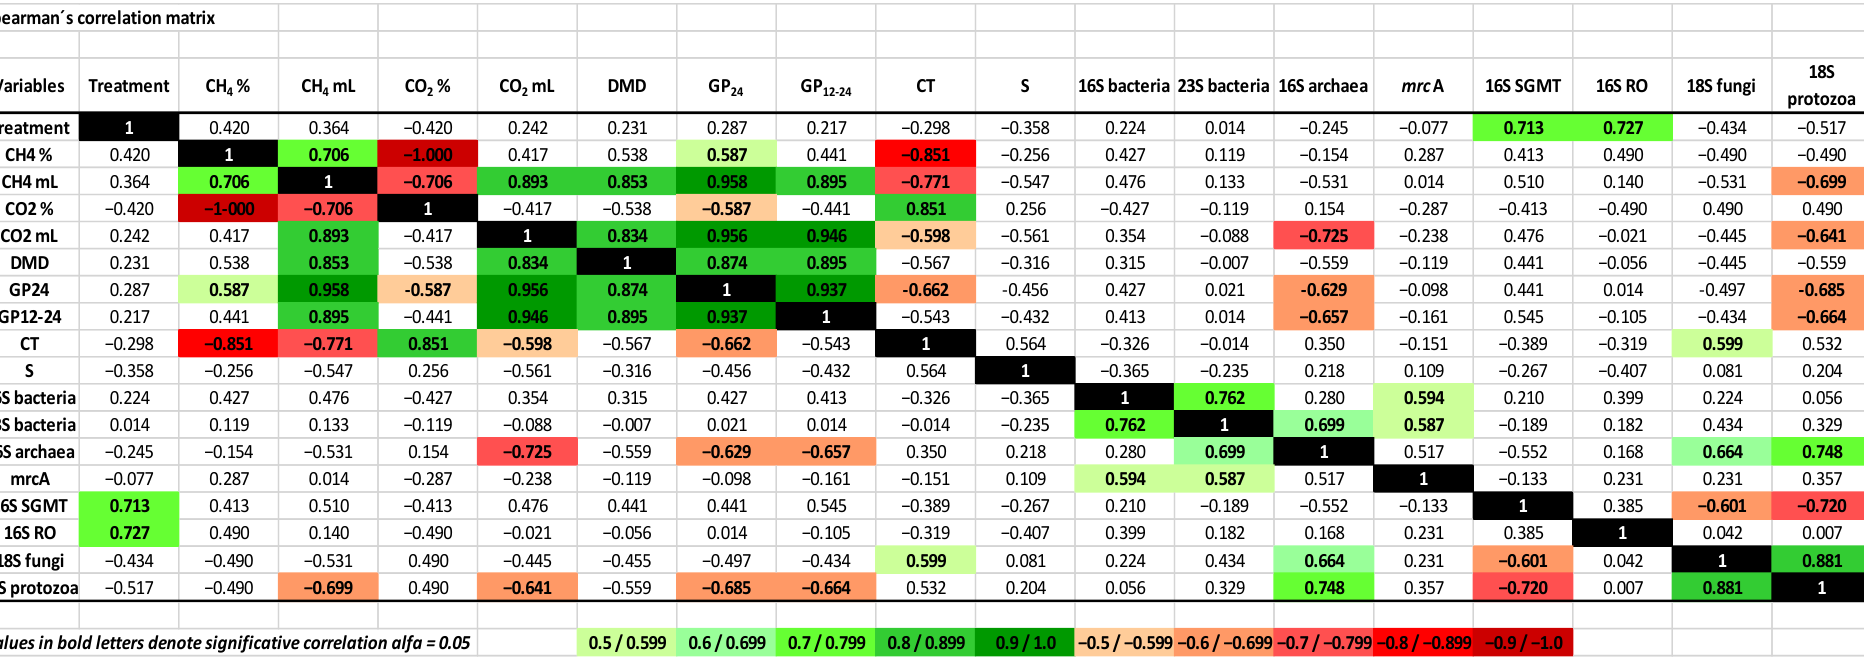
Figure 2. Heatmap of the correlation between methane and carbon dioxide production with fermentation variables, secondary metabolites and microbial populations. Values with a p < 0.05 are displayed in bold letters. Shades of green or red color, where darker color denotes higher significance values, indicate positive and negative correlation, respectively. Uncolored values indicate p > 0.05 . Black cells indicate correlation between the same variable. CH 4 % and CO 2 %: percentage of CH 4 or CO 2 in GP 12 – 24 ; CH 4 mL and CO 2 mL: CH 4 or CO 2 in GP 12 – 24 . DMD: dry matter degradability at 24 h (mg/g DM); GP 12 – 24 : gas produced between 12 and 24 h of fermentation (mL/g DM); GP 24 : accumulated gas production at 24 h (mL/g DM); CT: condensed tannins (%); S: saponins (%); 16S bacteria, 23S bacteria, 16S archaea, mcrA ( methyl co-enzyme M reductase alpha subunit ), 16S SGMT ( M. smithii , M. gottschalkii , M. millerae and M. thaueri ), 16S RO ( M. ruminantium and M. olleyae ), 18S fungi, 18S protozoa: copies/µL.